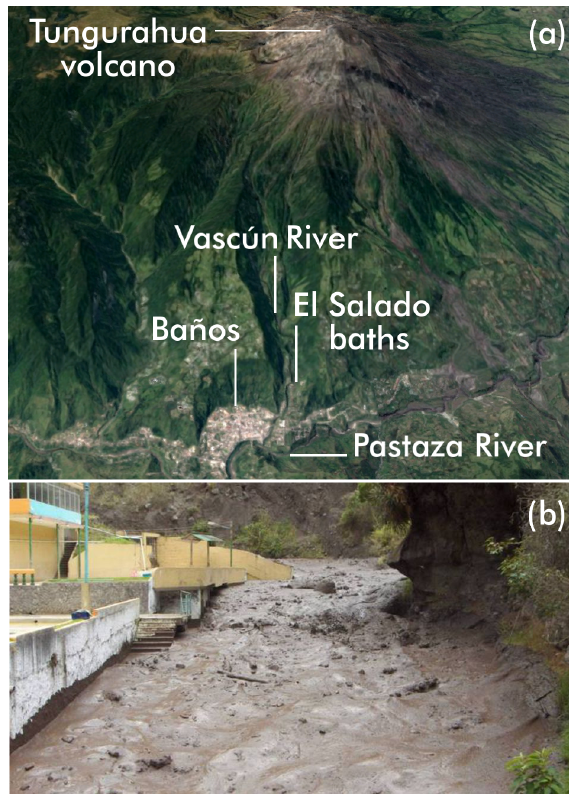
Figure 2. (a) © Google Earth view of Tungurahua volcano with indication of main localities of the study area; (b) 2005 lahar at thermal structure “El Salado”.